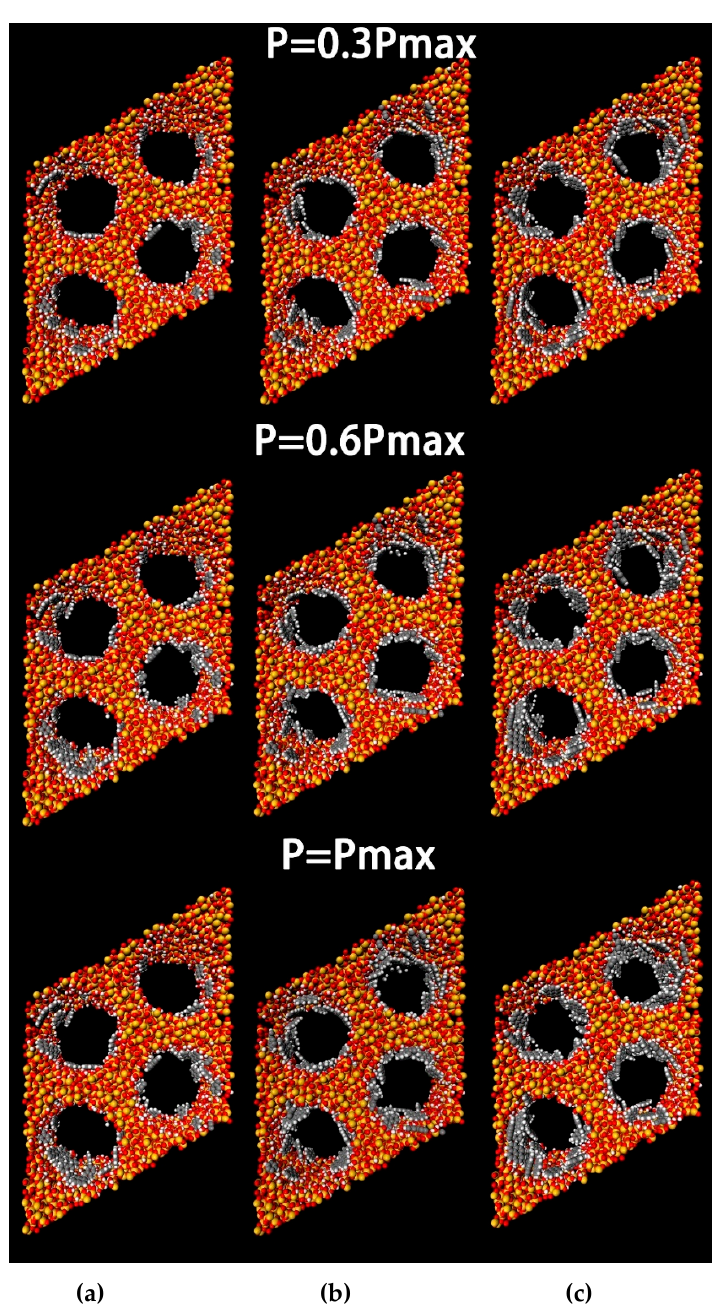
Figure 2. Typical configurations of Nap, Phe and Pyr adsorbed at 398K in the cylindrical nanopore of the model MCM-41. ( a ) Nap; ( b ) Phe; ( c ) Pyr, Key: Si, yellow; O, red; H, white; C, grey.